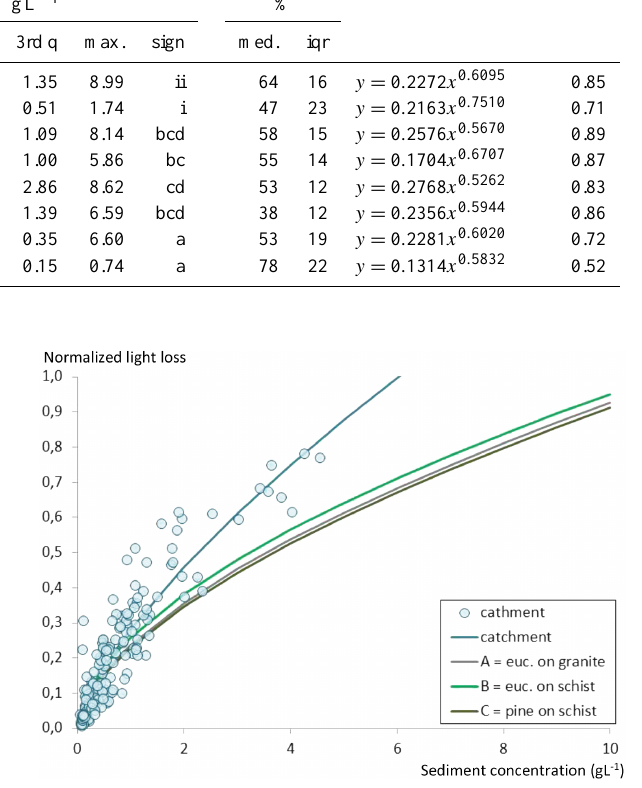
Figure 6. Relationships of sediment concentration with normalized light loss at the catchment scale (symbols), and best-fitting power functions at the catchment as well as slope scale for the eucalypt (euc.) and pine plantations located within the catchment (see Ta- bles 3 and